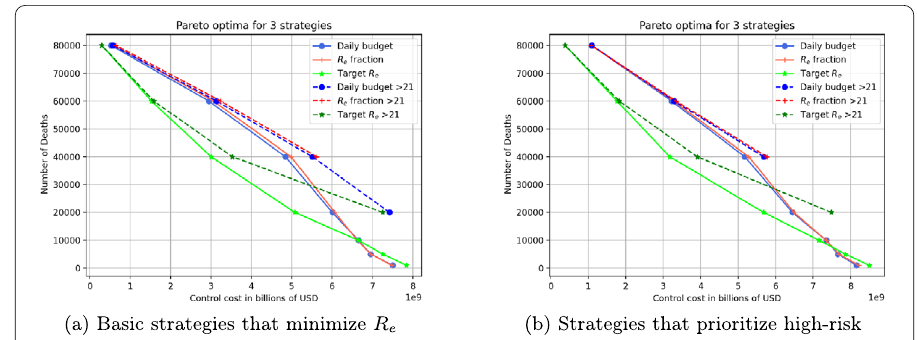
Figure 16 Number of the deaths associated to control cost depending on the starting control date for the three different strategies